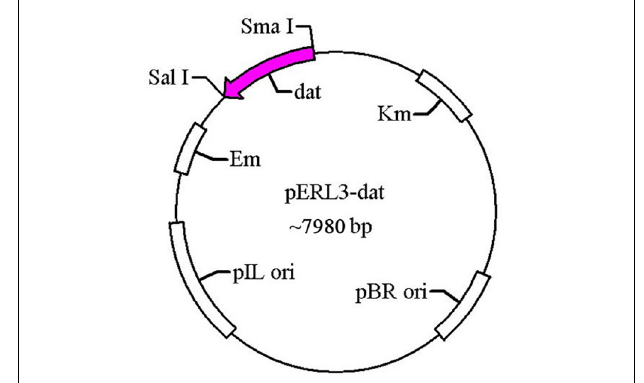
FIGURE 1 | Schematic diagram of recombinant plasmid pERL3-dat. The gene dat from EGDe was amplified using primers T1 and T2 and inserted at Sma I/ Sal I sites.